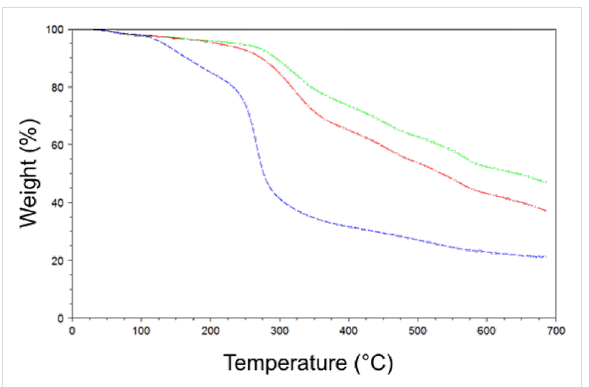
Figure 3: Thermogravimetric curves of the β -CD-based polymer after ultrafiltration with cut-off size of 3000 Da (blue line), 10000 Da (red line) and 30000 Da (green